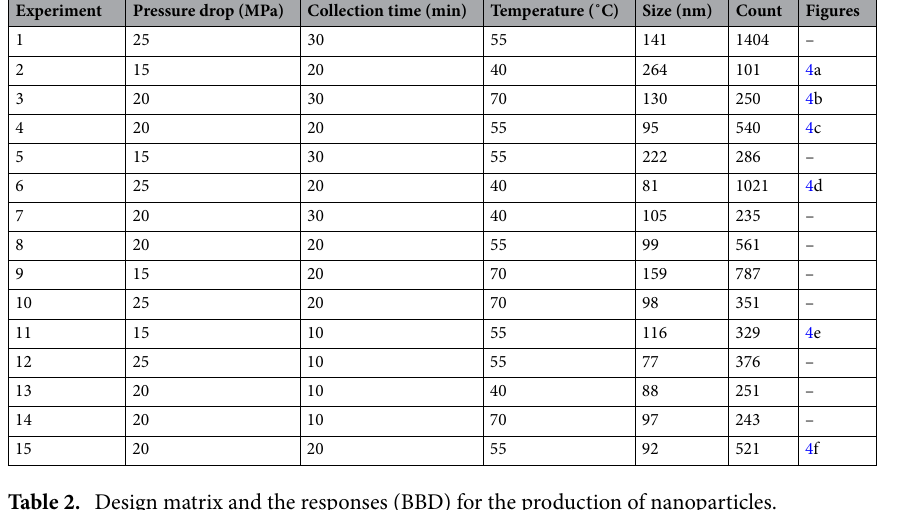
(Fig. 3e–j), only the interaction of pressure drop and the temperature has a significant effect (negative) on the number of particles. Pressure drop effect. In this study, the pressure drop was investigated in the range of 15–25 MPa. So that the secondary pressure was varied in selected values by the software (above the supercritical pressure of carbon dioxide), and the primary pressure was kept constant at 35 MPa. Pareto and main effect diagrams (Fig. 3a–d) showed that the pressure drop had the most significant effect on the size and number of formed nanoparticles. As the pressure drop decreases, the size of the particles formed decreases, and their number increases. To explain this phenomenon, it can be said that with increasing pressure drop, the density of SC-CO 2 and the collision between CO 2 molecules and the solute increases. According to the nucleation theory, increasing the solubility of the solute in CO 2 increases the relative supersaturation in the solution and decreases the particle size. More nucleation causes more particles to be produced 12,40 . This trend is observed until it reaches the optimal point, and then a reverse trend is observed due to the accumulation of particles. The effect of pressure on the formation of nanoparticles and related diagrams (experiments 2 and 3) is shown in Fig. 4a1,a2,b1,b2.